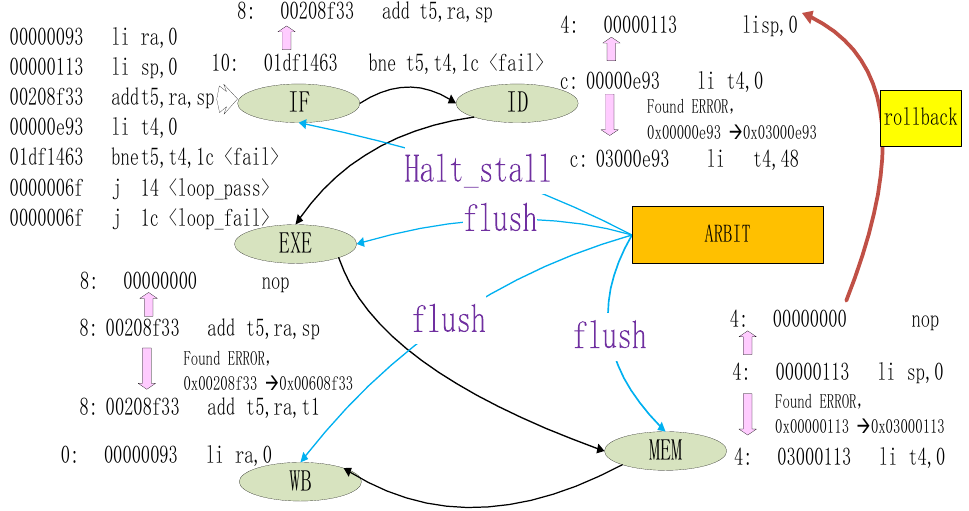
Figure 20. Program operation abnormal data flow 2.